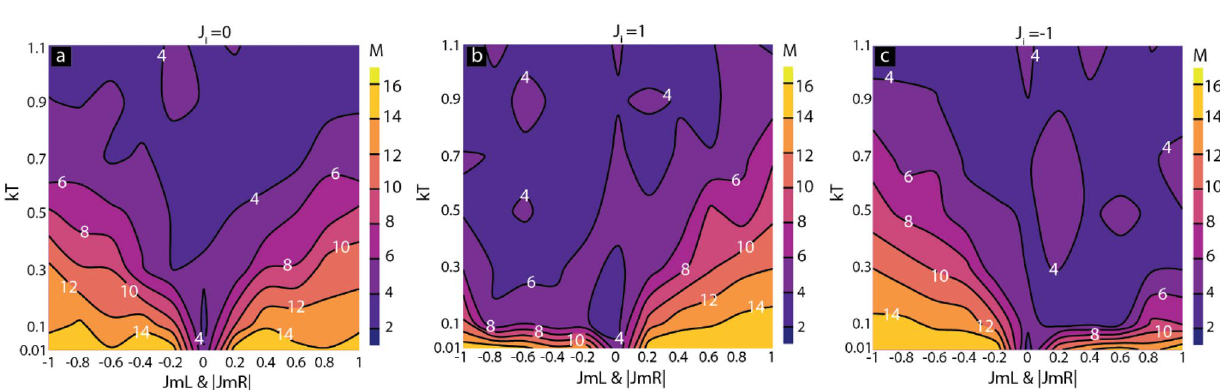
Figure 7. Effect of thermal energy and molecular coupling on MTJMSD magnetic moment under ( a ) no direct Energy, ( b ) ferromagnetic direct coupling, ( c ) antiferromagnetic direct coupling. Simulation data was plotted with the indigenously written Python code https:// colab. resea rch. google. com/ drive/ 1ACob 9eSsK m3oH4y_ X43rj LtVnf ockUTv? usp= shari ng. All the components were assembled in Adobe Illustrator CS6 version to produce the composite figure.